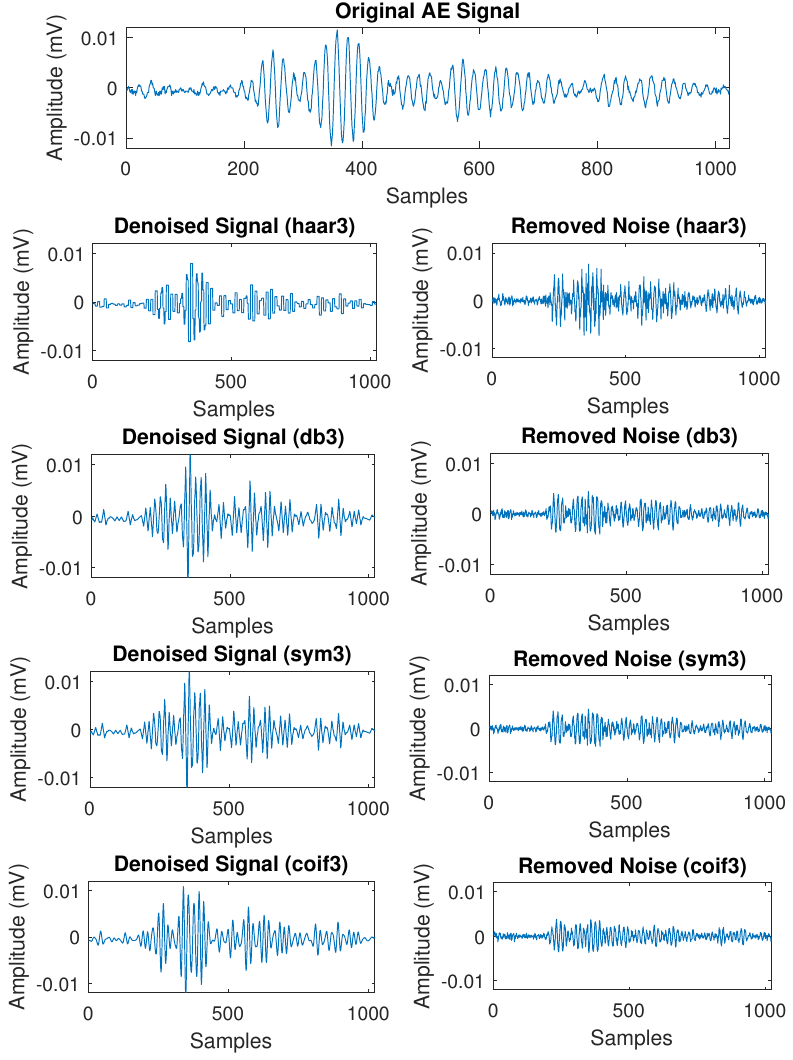
Figure 10. Noise reduction by WPT using haar3, db3, sym3 and coif3